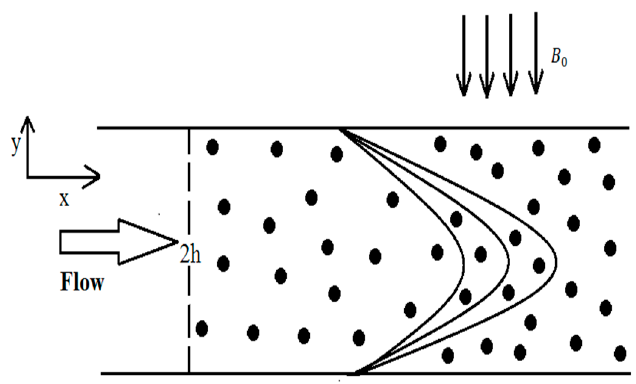
Figure 1. Particulate flow through slippery plates.